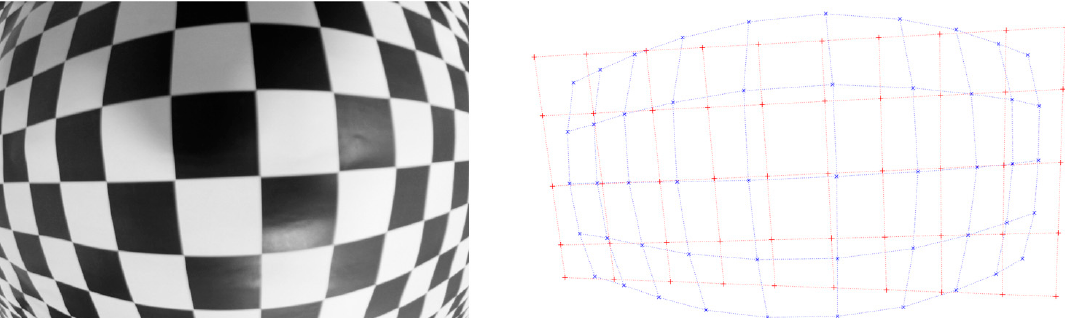
Figure 3. Result of control points correction. Blue dots correspond to detected distorted control points in the image q d,i and red lines correspond to the undistorted control points q p,i . Correction is done taking into account that control points of a checkerboard template accomplish two constraints that do not change under perspective projection. The first one is the cross ratio between any set of four control points and the second constraint is that control points that belong to a straight line in the checkerboard should remain in a straight line in the image.